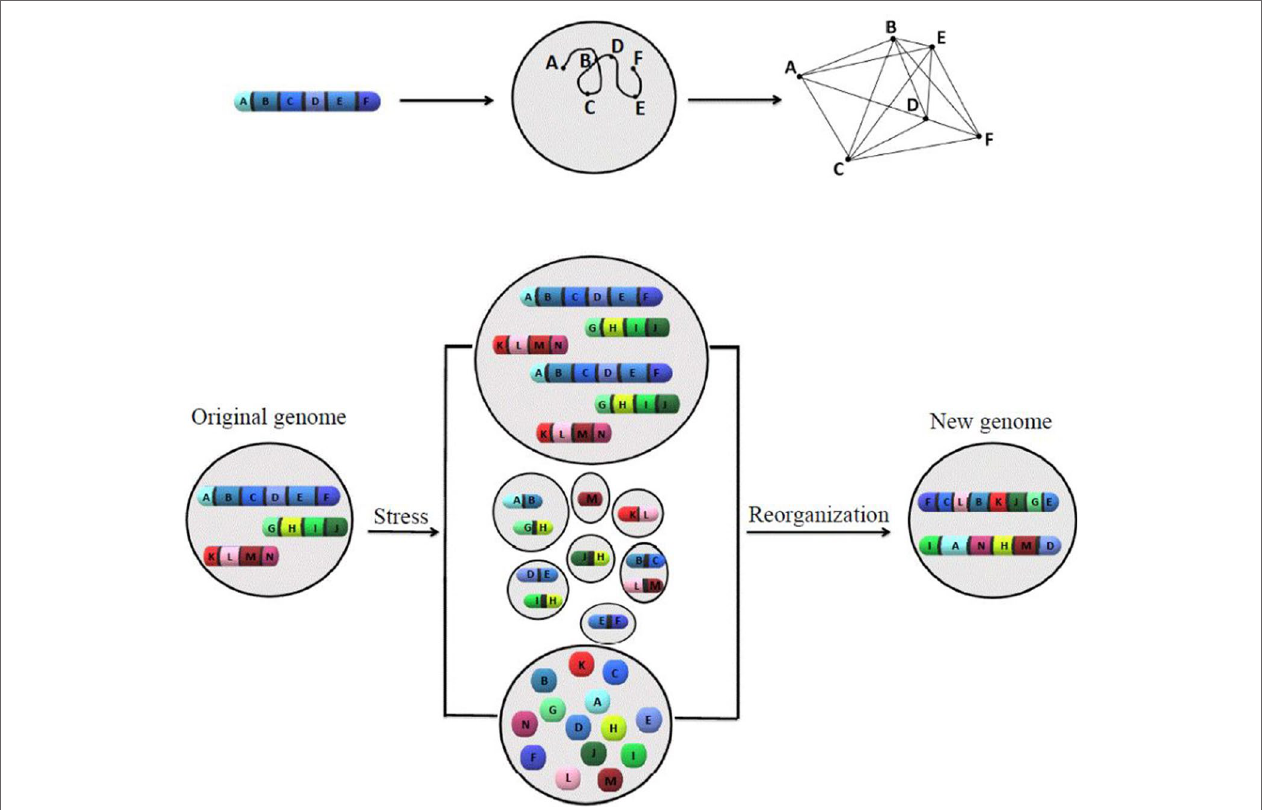
FIGURE 1 | The model of how karyotype or chromosomal coding defines the network structure, and how chromosomal/nuclear variation changes the chromosomal- coded system inheritance. The proposed models to illustrate the relationship between order of genes along chromosomes, network structure (upper panel), and how stress-induced genome re-organization creates a new genome through genome chaos (lower panel). The upper panel illustrates one chromosome with a gene order of A to F, its chromatin domain in interphase nuclei, and a defined network structure (from left to right). For simplicity, only one chromosome is shown. The pattern of interaction among multiple chromosomes would be more complicated. The lower panel illustrates the process of new genome emergence (from the original genome through different types of chromosome/nuclear re-organization under crisis). Only three chromosomes are presented for the original genome. Under high levels of cellular stress, genome chaos occurs as an effective survival strategy. Among many types of genome re-organization (including different types of genome chaos), only polyploidy (upper), micronuclei clusters (middle), and chromosomal fragmentation (lower) are shown. Additional types of genome chaos can be found in Heng et al. (2013a), Liu et al. (2014), and Heng, 2019. The result of genome re-organization (not dependent on the mechanism in which it proceeds) is the formation of new genomes with a higher chance of survival and new chromosomal codes reflected by two newly formed chromosomes with new gene order, providing new network